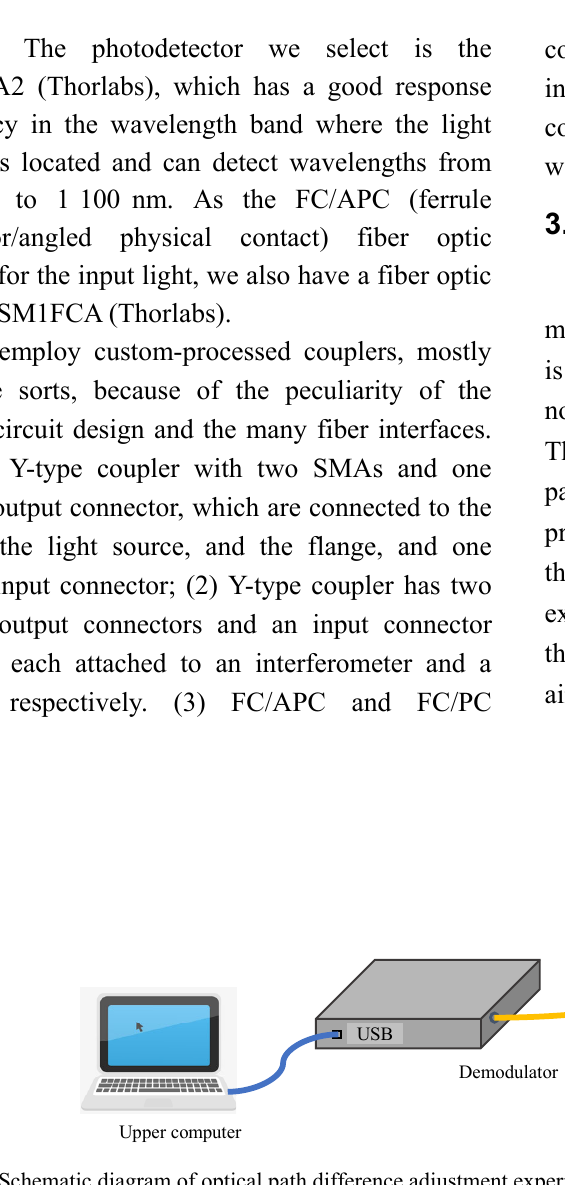
Fig. 9 Schematic diagram of optical path difference adjustment experiment of